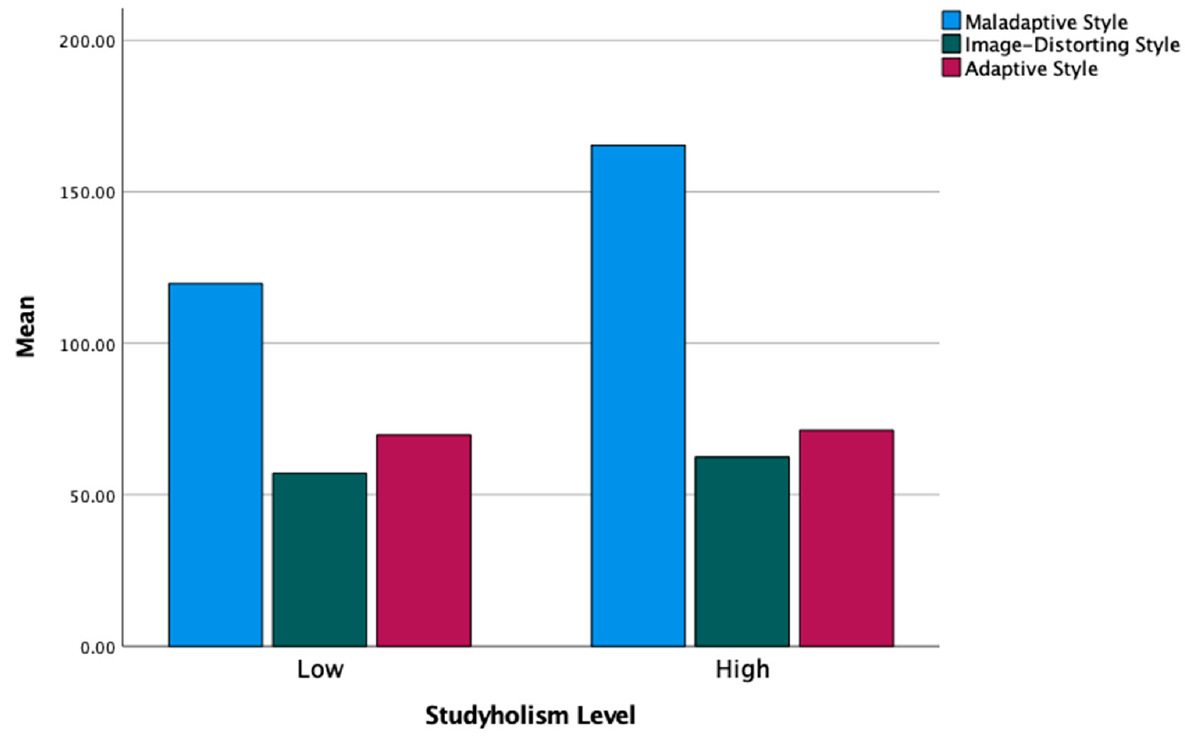
Figure 3. Mean levels of the three defense styles by low and high Studyholism.